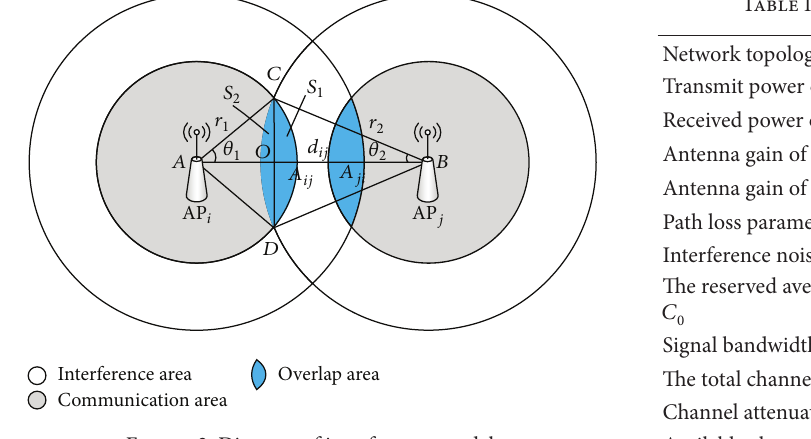
Figure 2: Diagram of interference model.